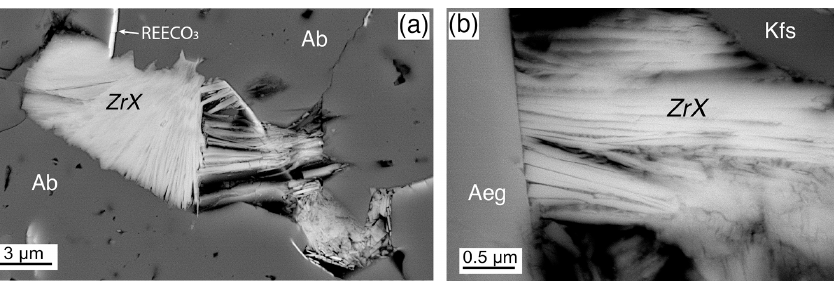
Figure 17. BSE images, Ailsa Craig microgranite, sample DV24828. (a) Typical texture of Zr-bearing fibrous phase ( ZrX ) in a vug in albite. (b) Zr-bearing fibers ( ZrX ), ∼ 100–200nm in width, in an open space between aegirine (Aeg) and K-feldspar